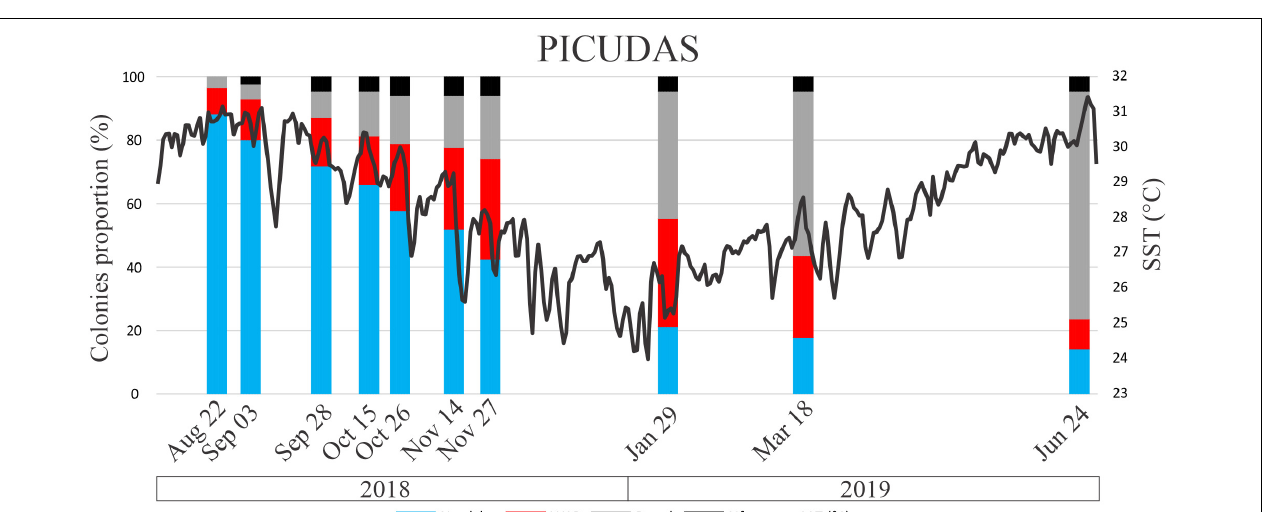
FIGURE 4 | Percentage of colony condition status through time of P. strigosa colonies at Bocana site. Nf is missing colonies. A continuous dark line indicates daily mean sea surface temperature (SST, ◦ C) at Puerto Morelos reef.